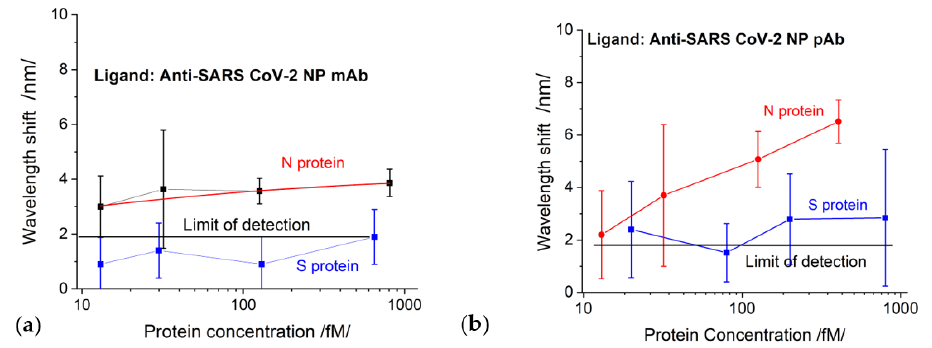
Figure 8. The displacement of SPR as a function of protein concentrations for chips functionalized with: ( a ) SARS-CoV-2 mAb; ( b ) SARS-CoV-2 pAb.